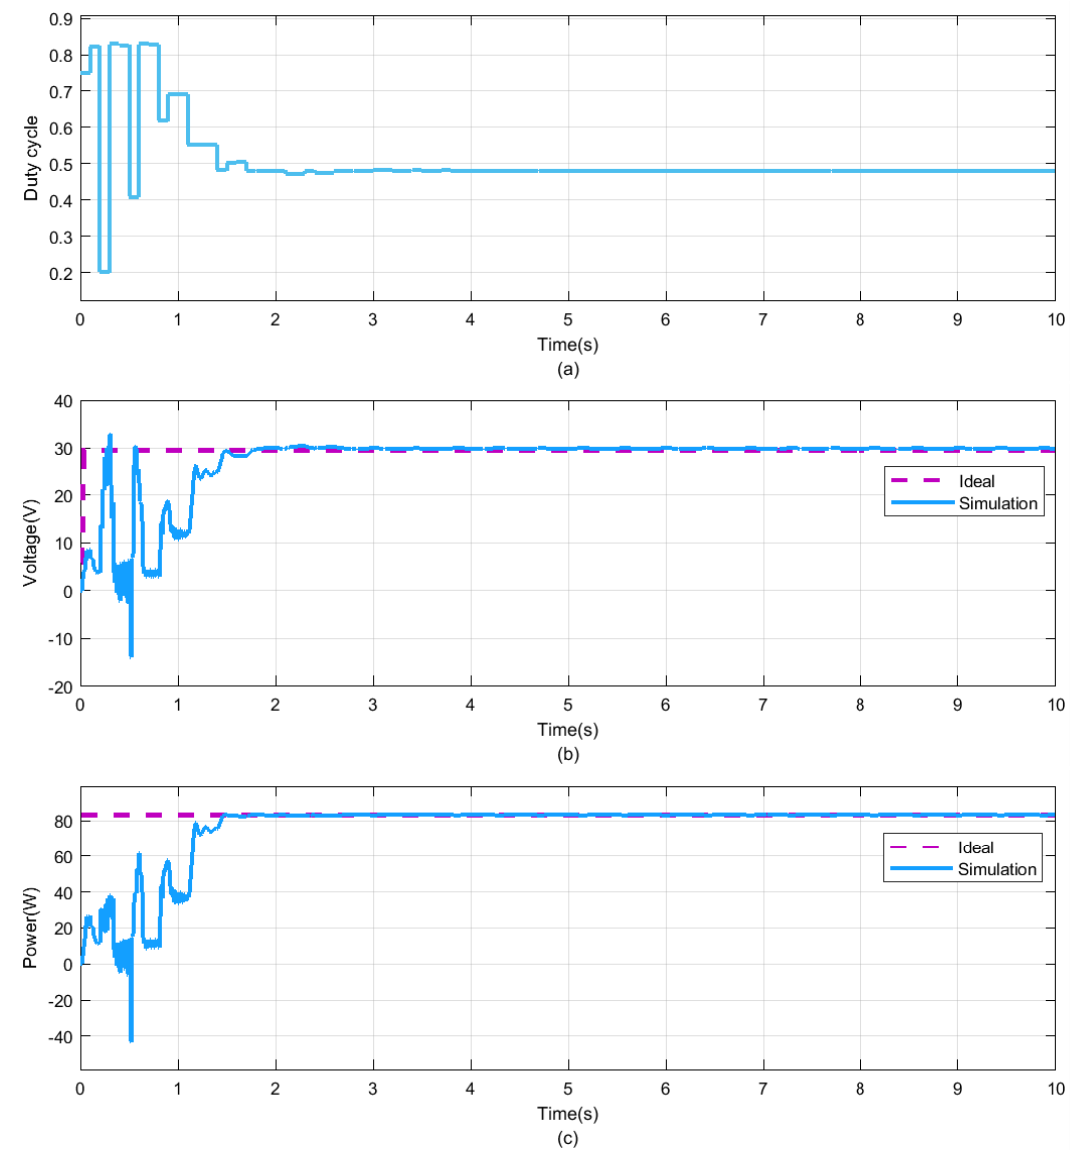
Figure 6. Simulation results under G = 800 W/m 2 , Tc = 48 ◦ C and Np = 3 given by the Improved Particle Swarm Optimisation (IPSO) algorithm: ( a ) Duty cycle, ( b ) Voltage, and ( c )